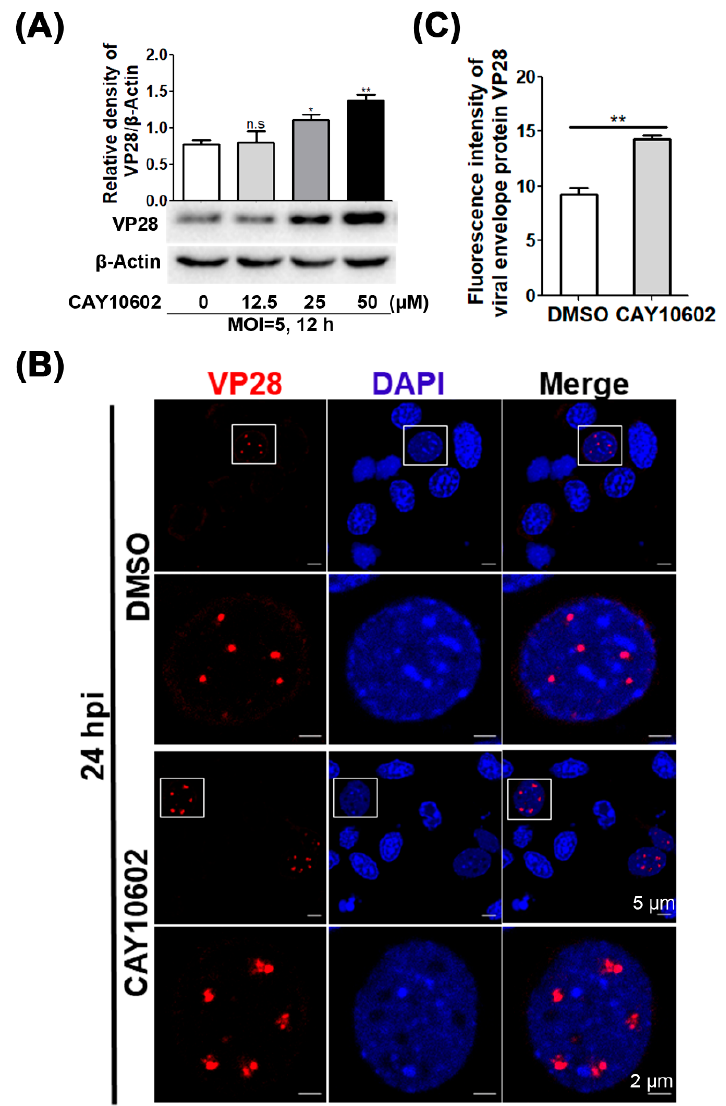
Figure 4. Enhancement of Cq SIRT1 deacetylase activity promoted VP28 protein expression. ( A ) VP28 protein was significantly increased in Hpt cells through the activation of deacetylase with the activator CAY10602. VP28 protein level was determined using Western blot analysis. β -actin was used as an inter-control. The relative quantitation of VP28 protein expression was conducted with histogram analysis. ( B ) VP28 protein was strongly aggregated in the nuclei of Hpt cells treated with CAY10602. The fluorescence signal of VP28 (red) was observed under a laser confocal microscope. ( C ) The relative quantitation of the fluorescence intensity of VP28 was determined with histogram